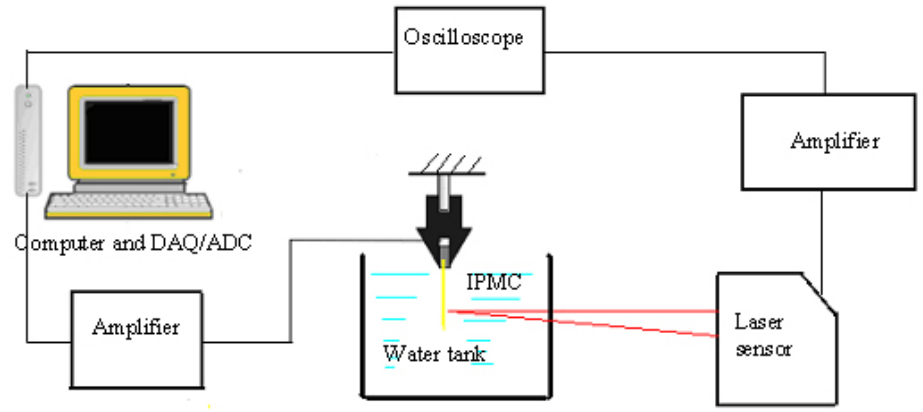
Figure 5. Deflection measurement system for the IPMC actuator.